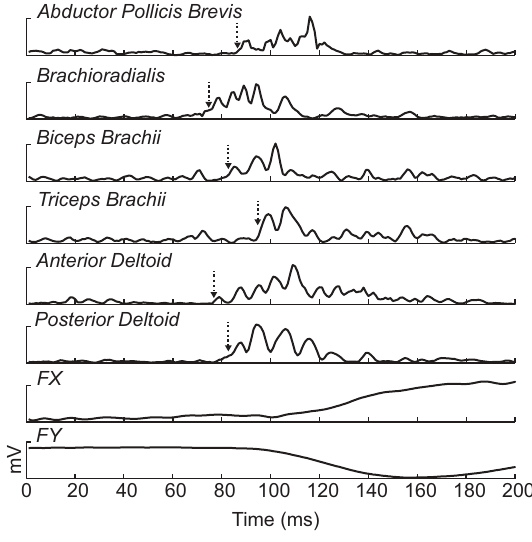
Figure 2. Representative data from one subject in the NEUT position where each trace represents the average of 8 individual stimulation responses. The average onset time is indicated by the dashed line with the arrow. The DC offset was removed and the signals were rectified prior to averaging for each channel. The time window is from the stimulation onset-200ms.